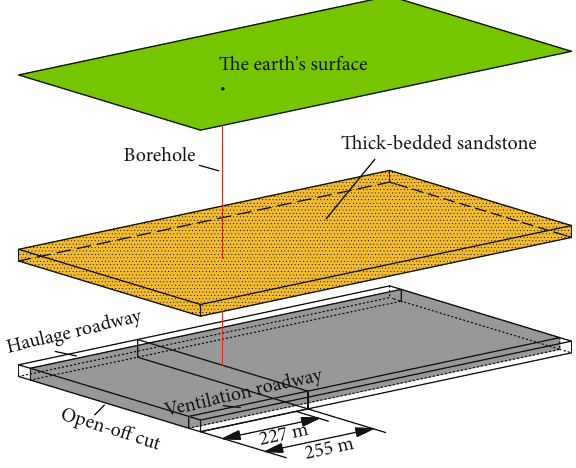
Figure 5: Illustration of the drilling position on the